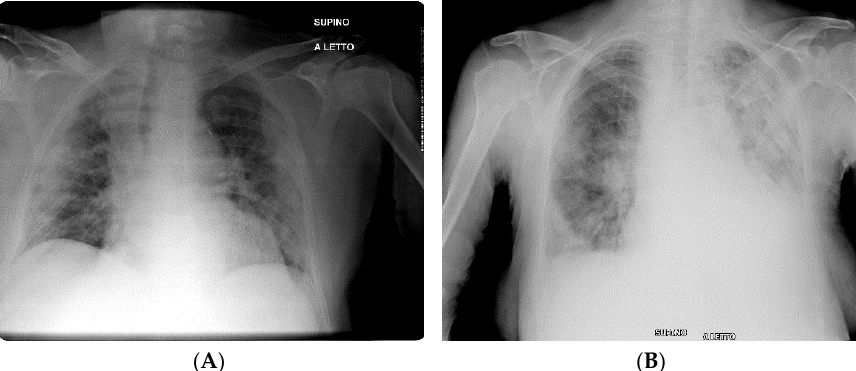
Figure 1. Examples of CXR scores in two patients with COVID-19 pneumonia. ( A ) presents consolidation with basal, peripheral, and bilateral predominance (right lung score + left lung score = total score; 3 + 3 = 6). ( B ) presents areas of consolidation and ground-glass opacity with subpleural and basal predominance in right lung, and diffuse areas of consolidation and ground-glass opacity in left lung (the calculation right lung score + left lung score = total score; 3 + 4 = 7).